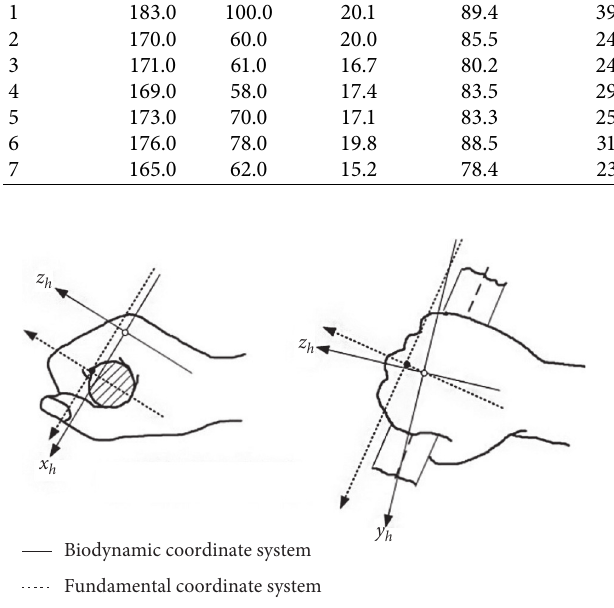
Figure 2: Hand grip coordinate